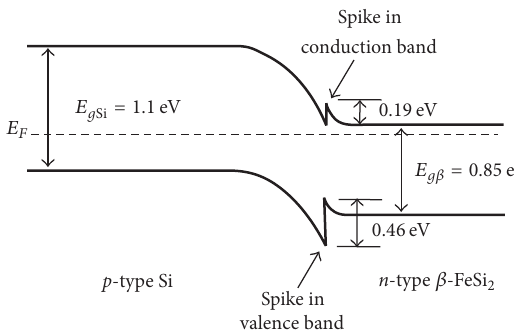
Figure 8: Energy band diagram that indicates the spikes in conduc- tion and valence bands for n-type 𝛽 -FeSi 2 /p-type Si